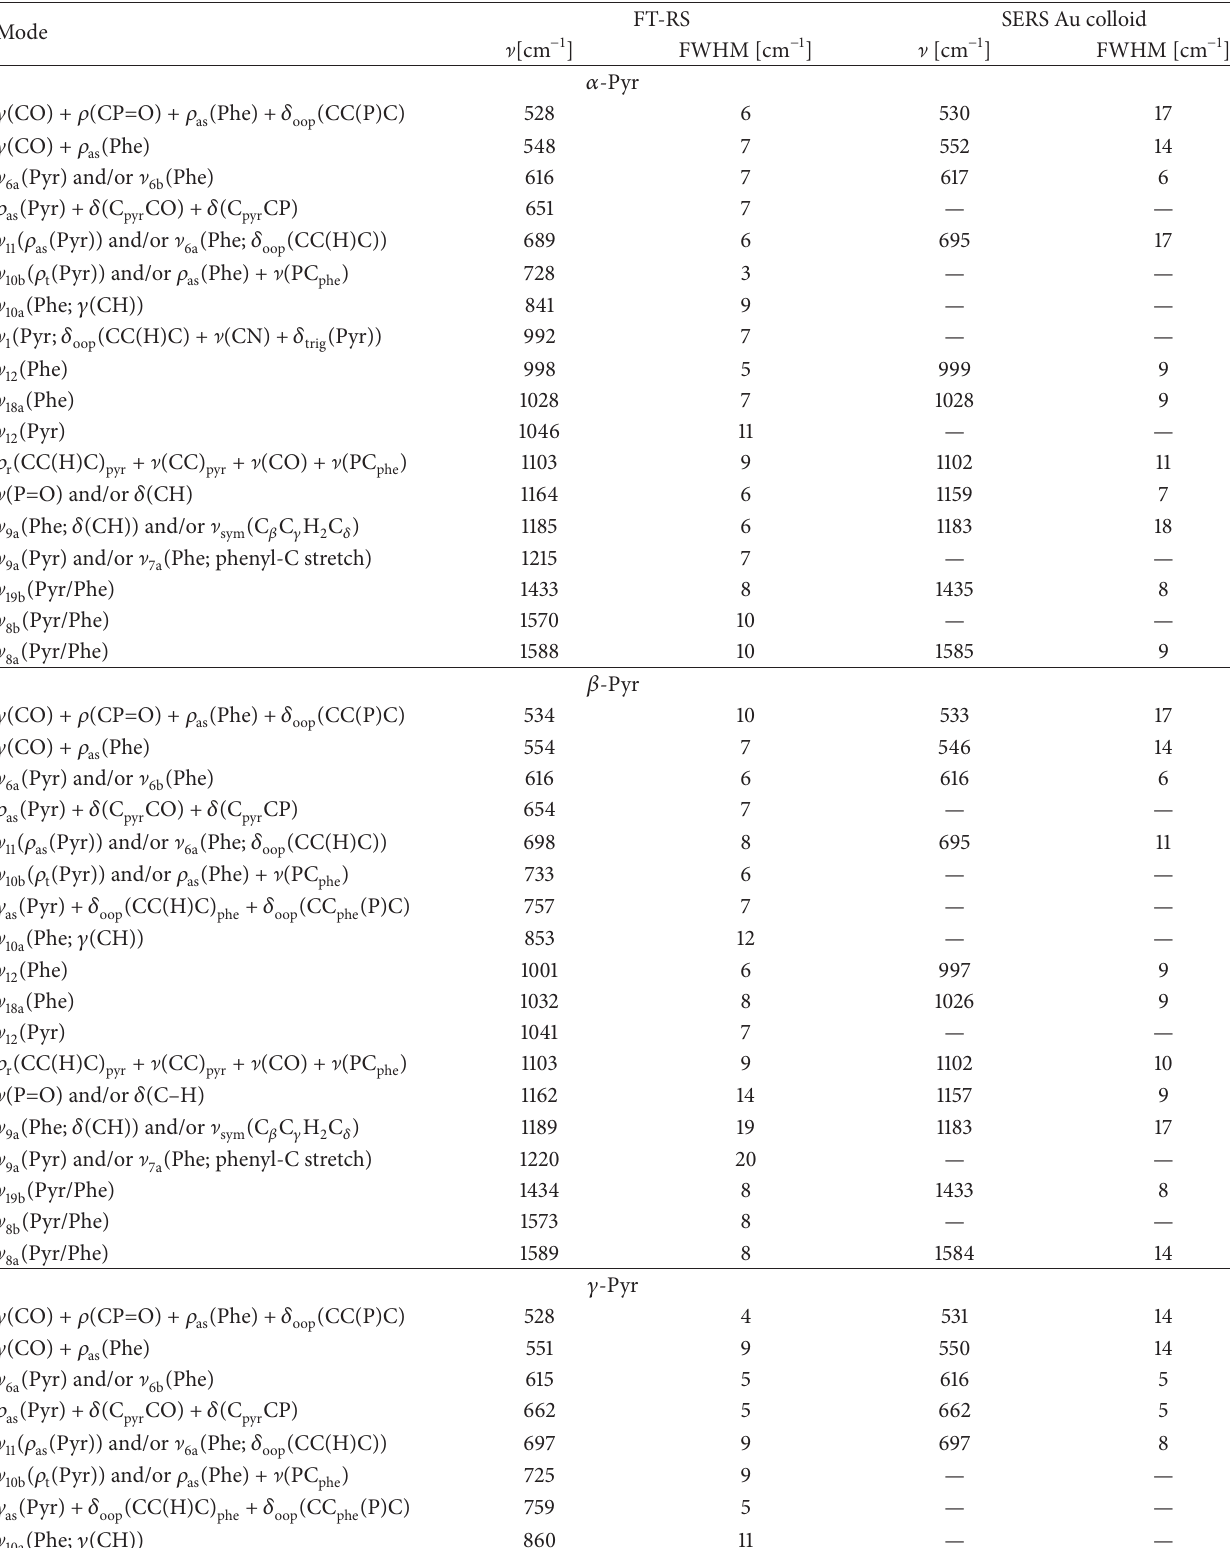
Table 2: Wavenumbers, full band widths at half maximum, and proposed band assignments for FT-RS and SERS spectra of 𝛼 -Pyr, 𝛽 -Pyr, and 𝛾 -Pyr adsorbed onto colloidal gold